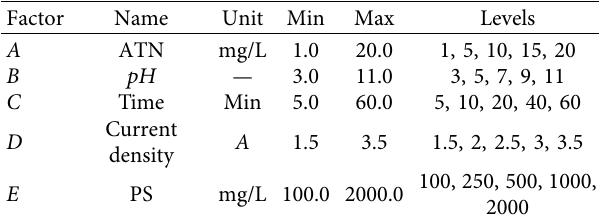
Figure 1: Schematic diagram of the reactor used in this study: (1) ultrasonic bath; (2) laboratory scale reactor; (3) iron electrode; (4) copper electrode; and (5) DC power supply.